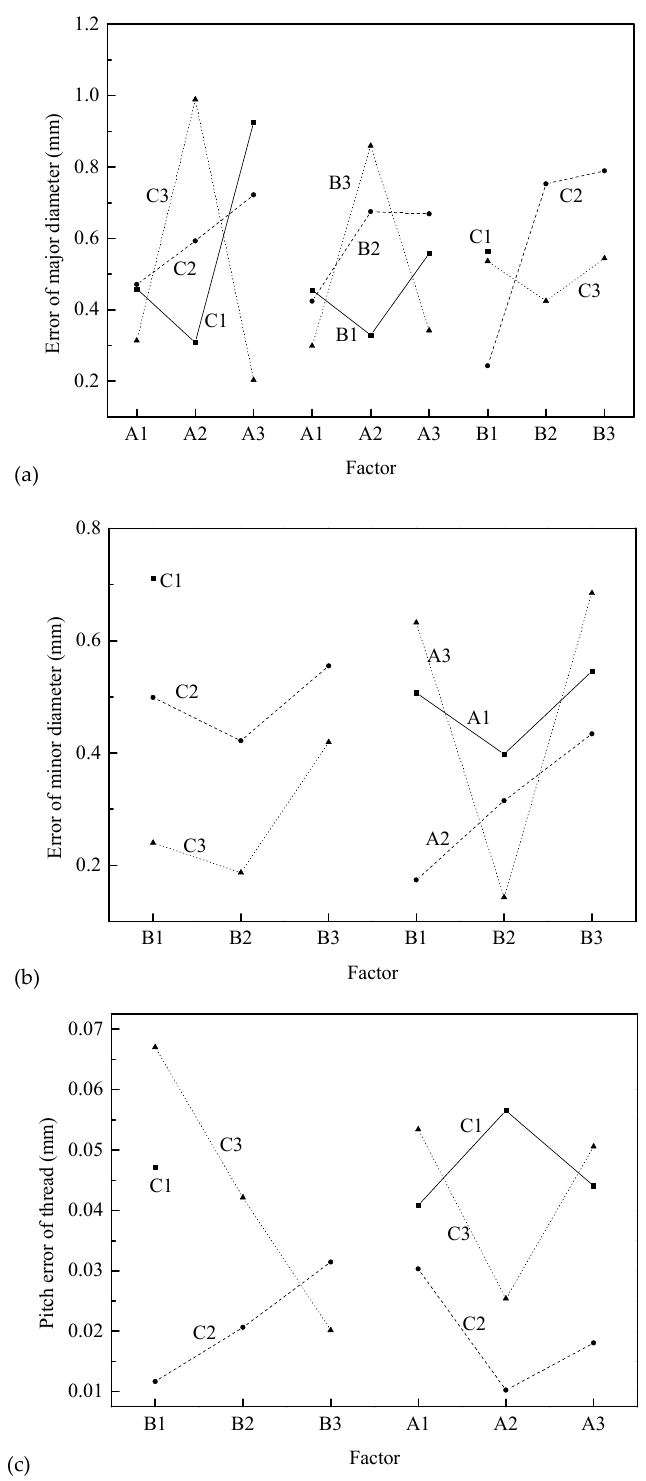
Figure 13. Interactions among factors for the error of geometrical parameters of the threaded section: ( a ) error of major diameter, ( b ) error of minor diameter, ( c ) pitch error of thread.